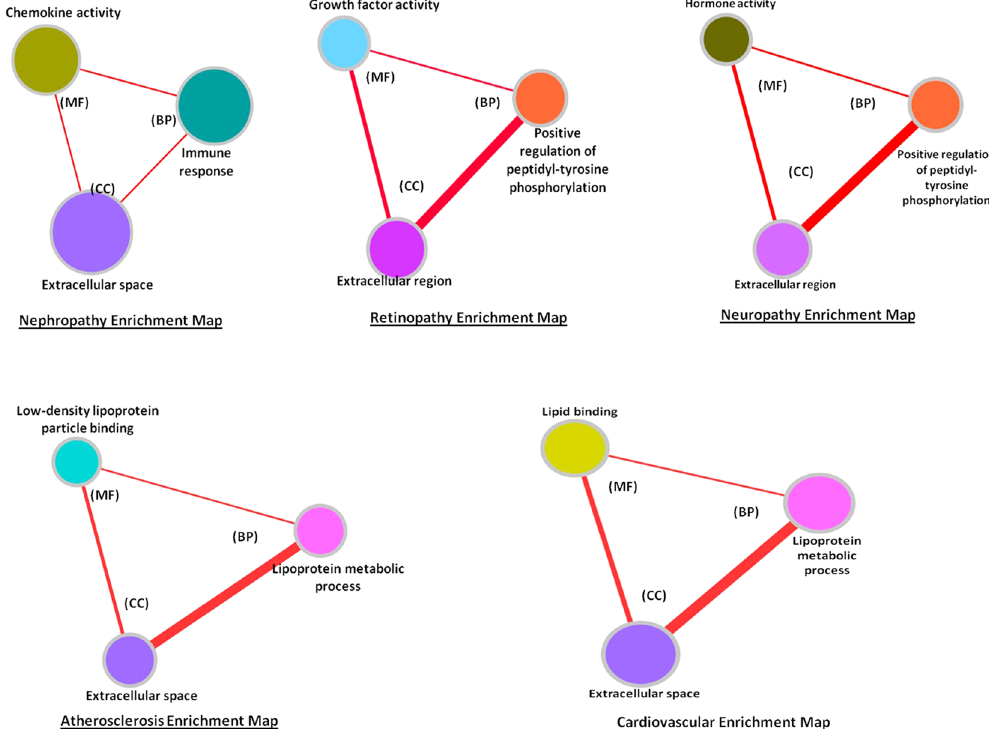
Figure 5. Gene-set enrichment visualization using EnrichmentMap. In the graph, nodes represent gene set involved in the GO term mentioned adjacent to the node and edges represent the extent of overlap of genes between the two gene sets connected by them. Node size and edge width are proportional to the number of genes. Colour representation Purple = Extracellular space, Violet = Extracellular region, Orange = Positive regulation of peptidyl-tyrosine phophorylation, Olive = Chemokine activity, Army green = Hormone activity, Pine green = Immune response, Light blue = Growth factor activity, Turquoise = Low-density lipoprotein particle binding, Yellow green = Lipid binding, Pink = Lipoprotein metabolic